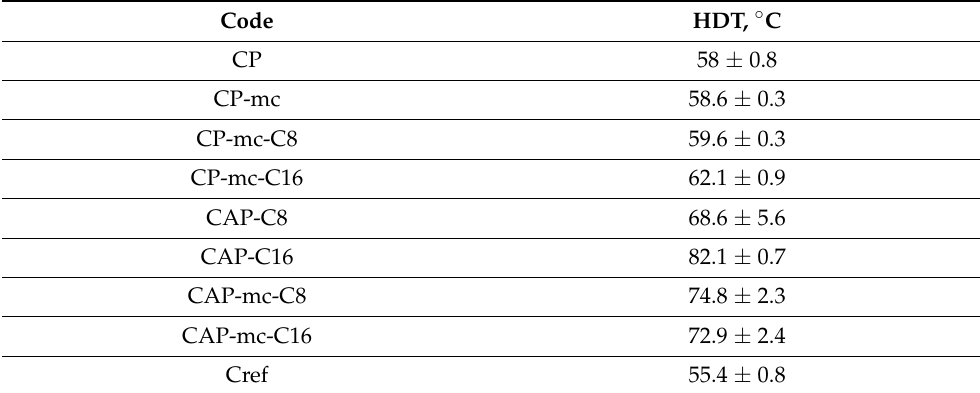
Table 4. HDT-results for injection molded